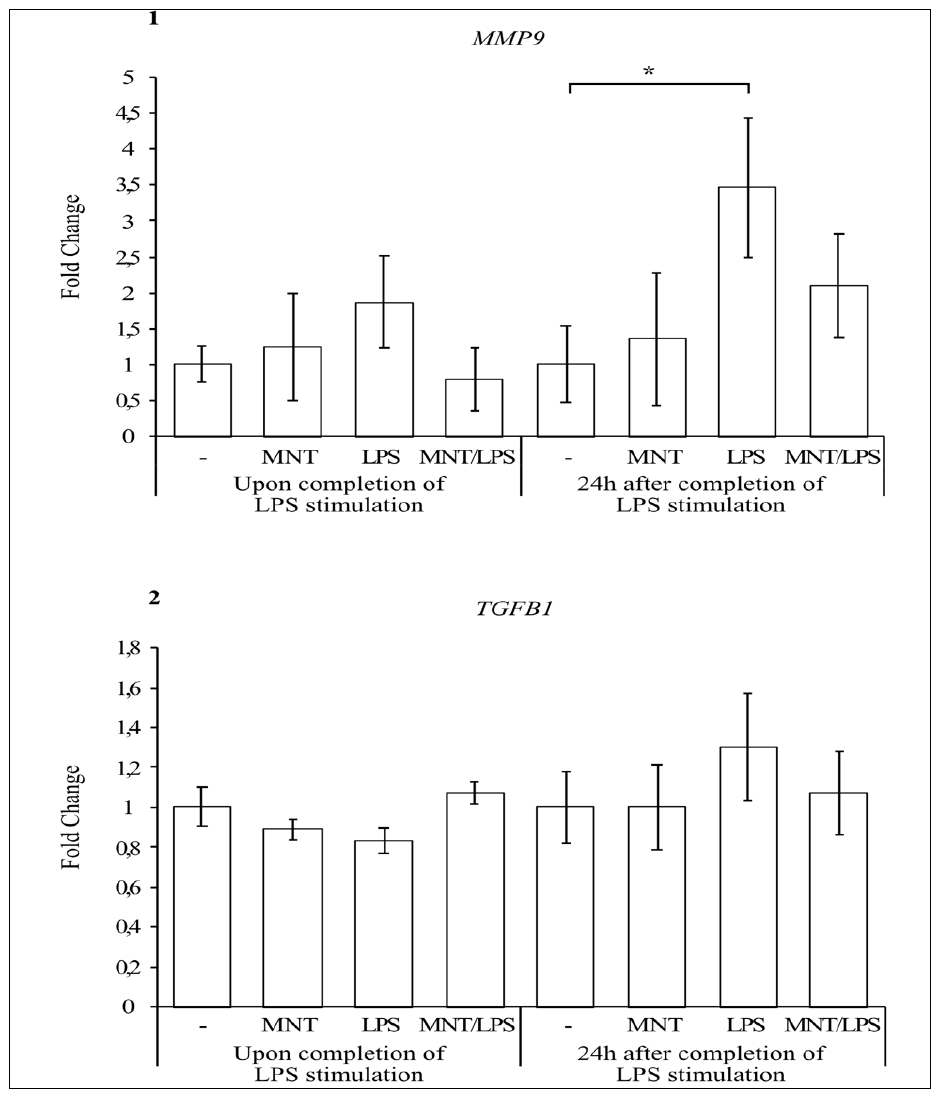
Figure 2. Effect of montelukast pretreatment on the expression of genes involved in the airway remodeling. BEAS-2B cells were subjected to indicated agents. Analysis of MMP9 (1) and TGFB1 (2) gene expression at the mRNA level was performed at two-time points after LPS stimulation. GAPDH gene expression was used as endogenous control (representative of n = 3) and gene expression in untreated control cells was used as a calibrator. Differences between the two treatments were analyzed by the Independent Samples Mann Whitney U test. Obtained p values were evaluated by Benjamini-Hochberg method. Results are presented as mean ± standard deviation. * P<0.05; MMP9 − Matrix metaloprotenase 9; TGFB1 − transforming growth factor beta 1; MNT − Montelukast; LPS −